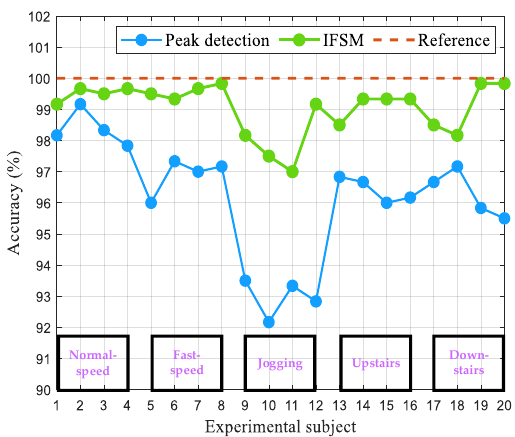
Figure 11. The error of gait detection.